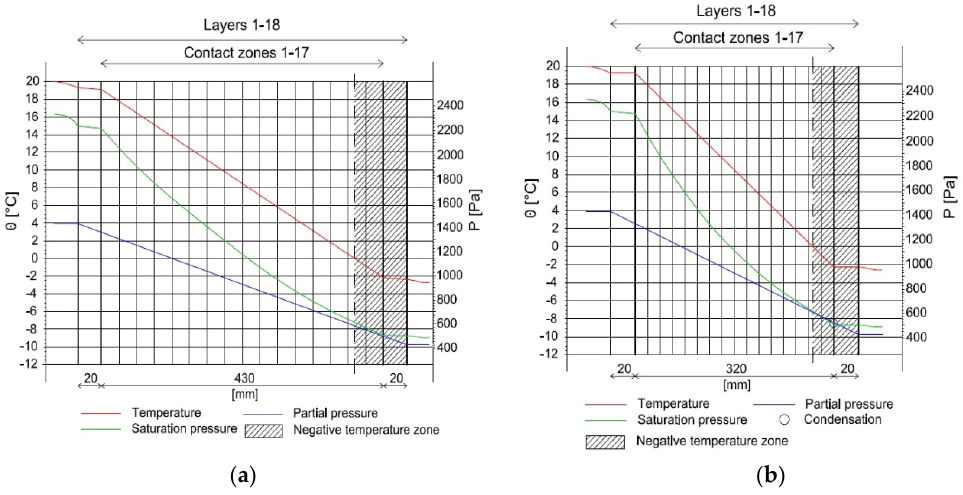
Figure 12. Distribution of temperature and water vapor pressure in ( a ) wall H1 and ( b ) wall FH1 for